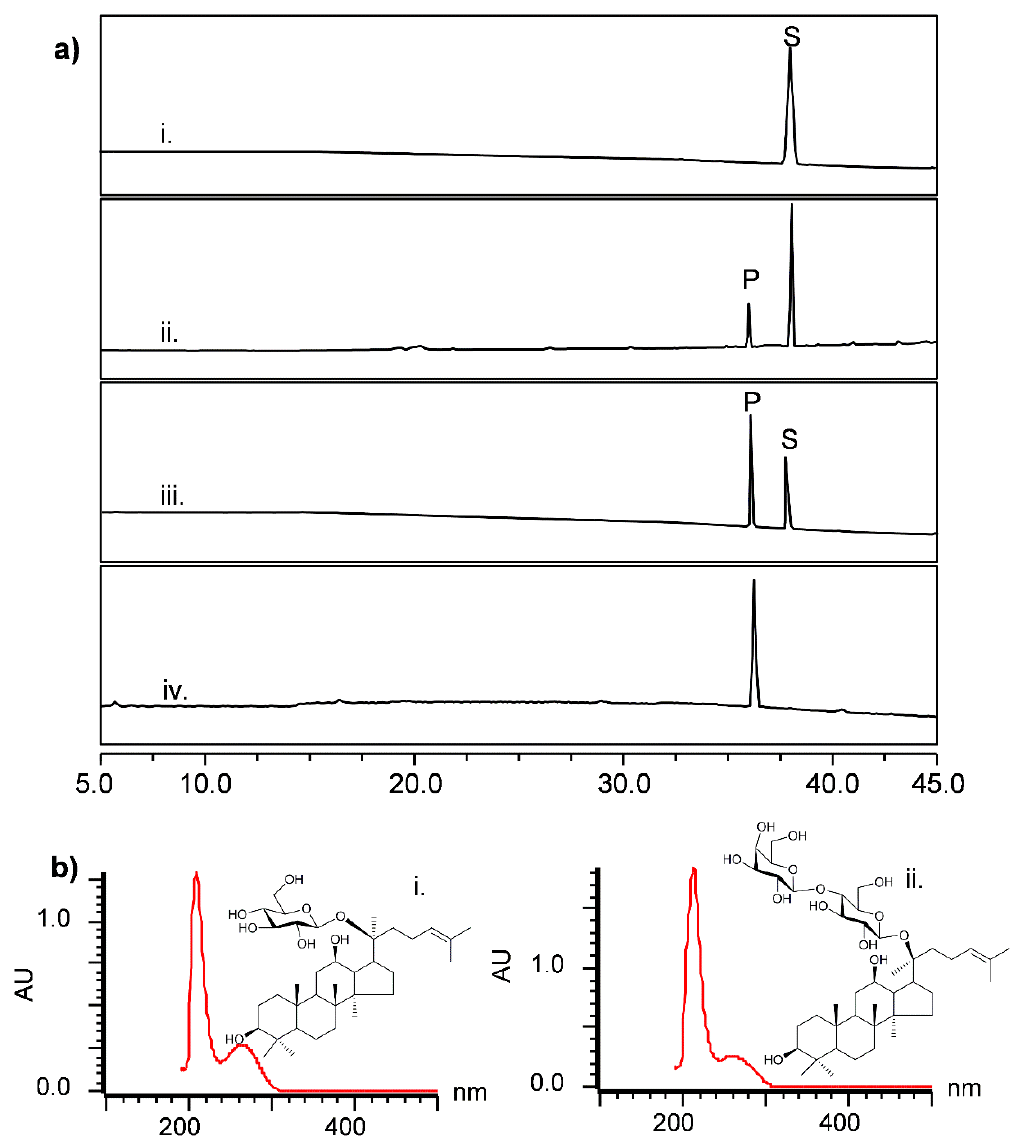
Figure 2. HPLC of the glycosylation reaction of compound K (CK) by purified recombinant LgtB. ( a ) HPLC analysis of the reaction of CK; Control (i), Reaction at 0.5 h (ii), reaction at 1 h (iii), and reaction at 3 h (iv). ( b ) UV maxima of (i) CK (S), and (ii) CKGal (P). S refers to substrate and P refers to product.